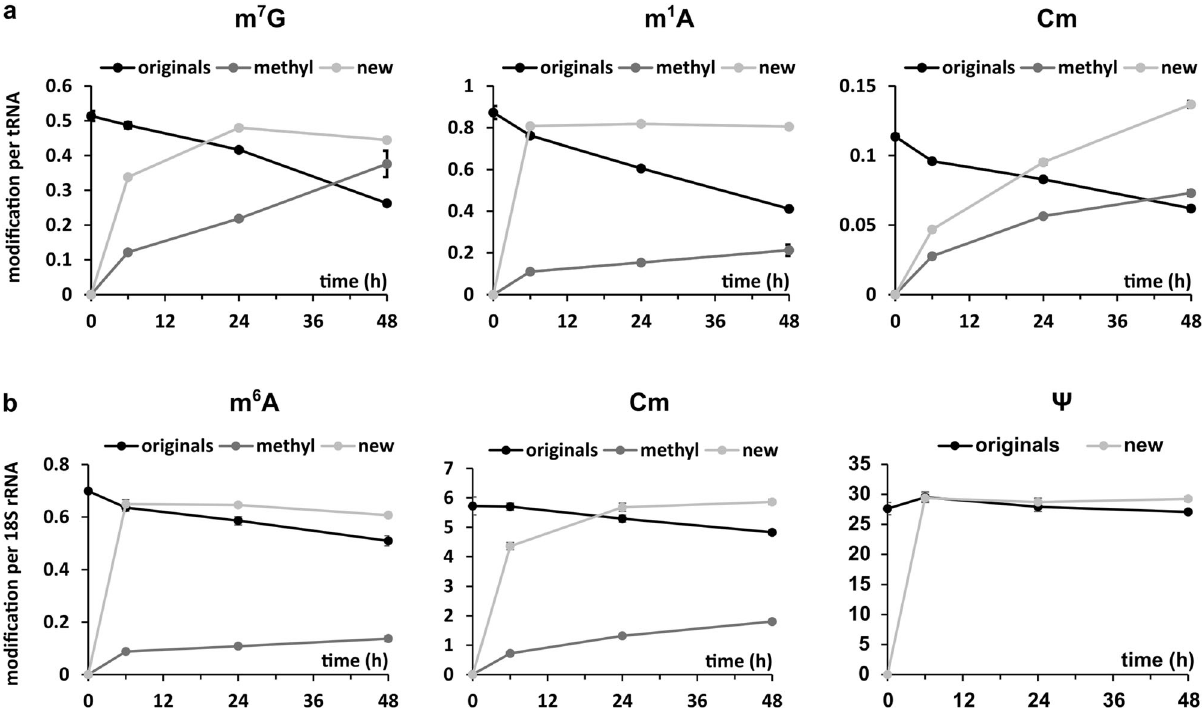
Fig. 5 Dynamics of modi fi ed nucleosides in total tRNA and 18S rRNA. a Results for total tRNA. b Results for 18S rRNA. Original nucleosides (originals, black line) existed before experiment initiation. Post-methylated nucleosides (methyl, dark grey line) are modi fi cations arising from the methylation of original RNA after experiment initiation. New nucleosides (new, light grey line) show the incorporation of modi fi cation into new transcripts. Data points re fl ect the mean and standard deviations of n = 3 biol.